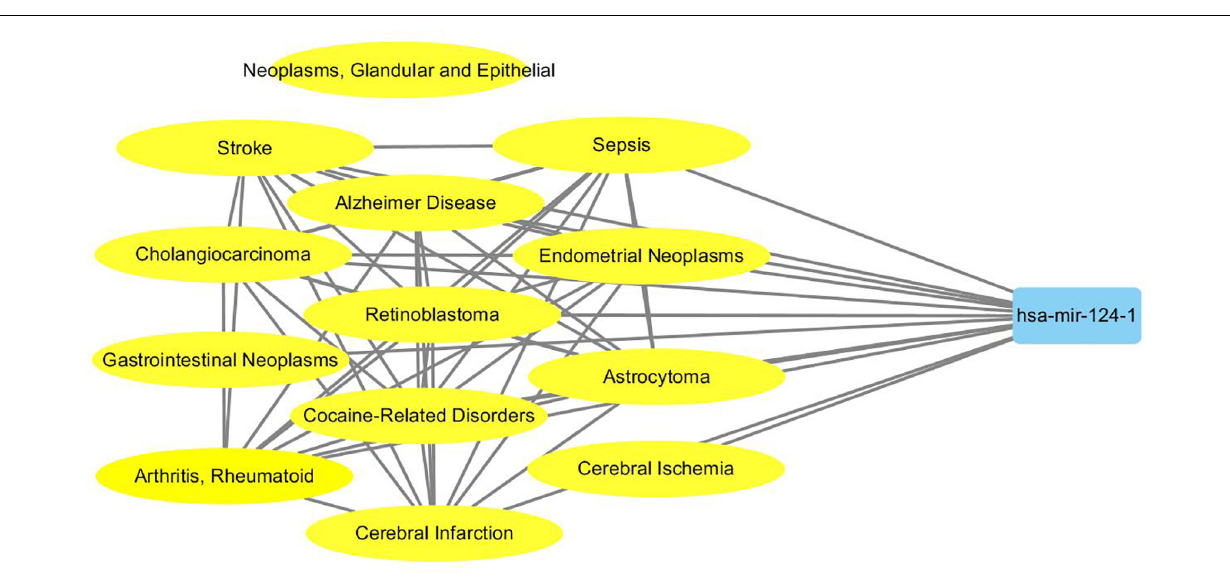
FIGURE 4 | An example of disease module detected by MDN-NMTF2 on HMDD2.0-Yan Dataset. The figure shows that 12 of 13 diseases in the module are related to a miRNA